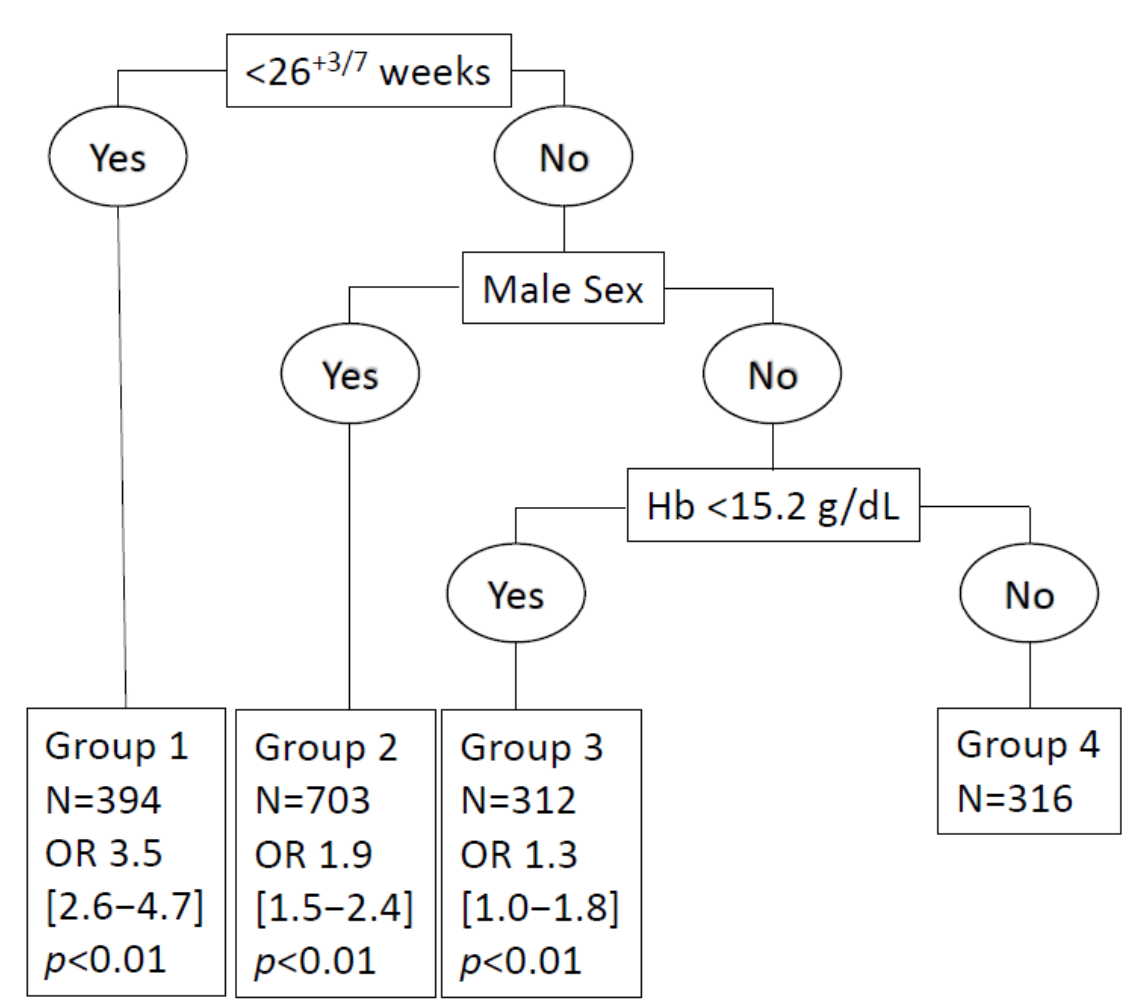
Figure 2. Risk stratification tree to predict non-optimal neurodevelopmental outcomes at 24